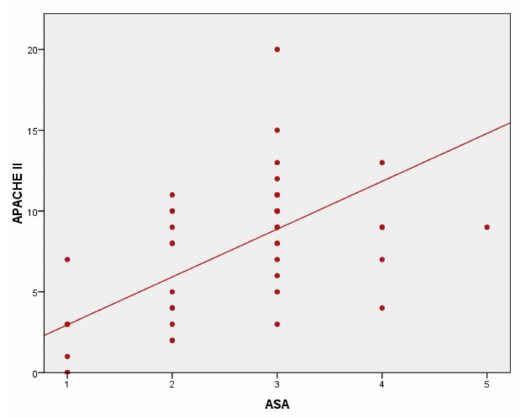
Figure 3. ASA score–Acute Physiology and Chronic Health Evaluation (APACHE II) correlation.